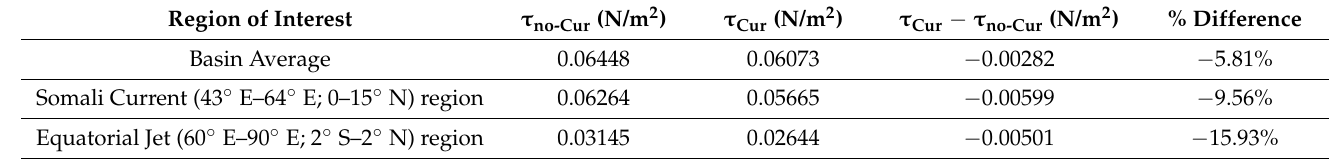
Figure 2. Zonal average of wind stress difference ( τ Cur − τ no-Cur ; N/m 2 ) in the tropical Indian Ocean. Table 1. Area averaged wind stress during 2007–2020.